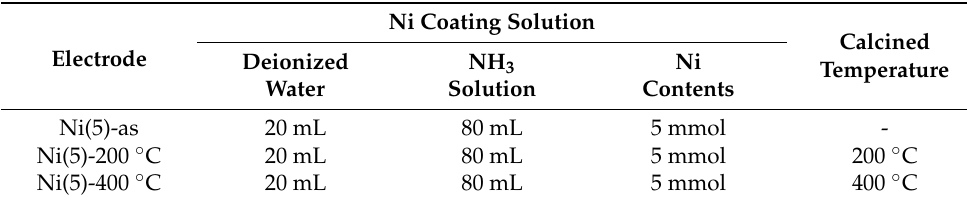
Table 1. Nomenclature of Various Ni electrodes by calcination condition.